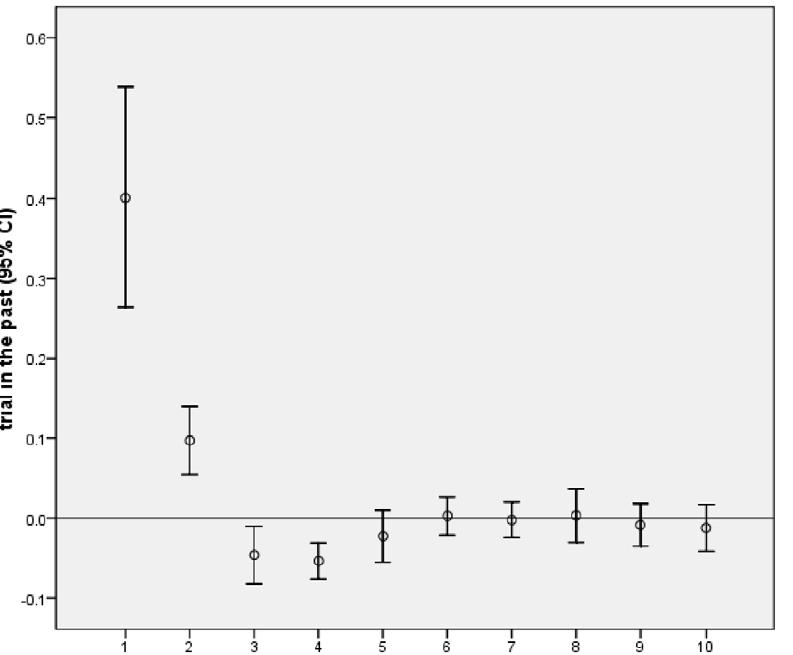
Figure 4. Results for testing JC. Correlation of current prediction with what happened on the nth trial in the past plotted against trials into the past (n). JC shows a stronger influence of recent trials than normal controls, and normal controls show a stronger influence of distant trials than JC.